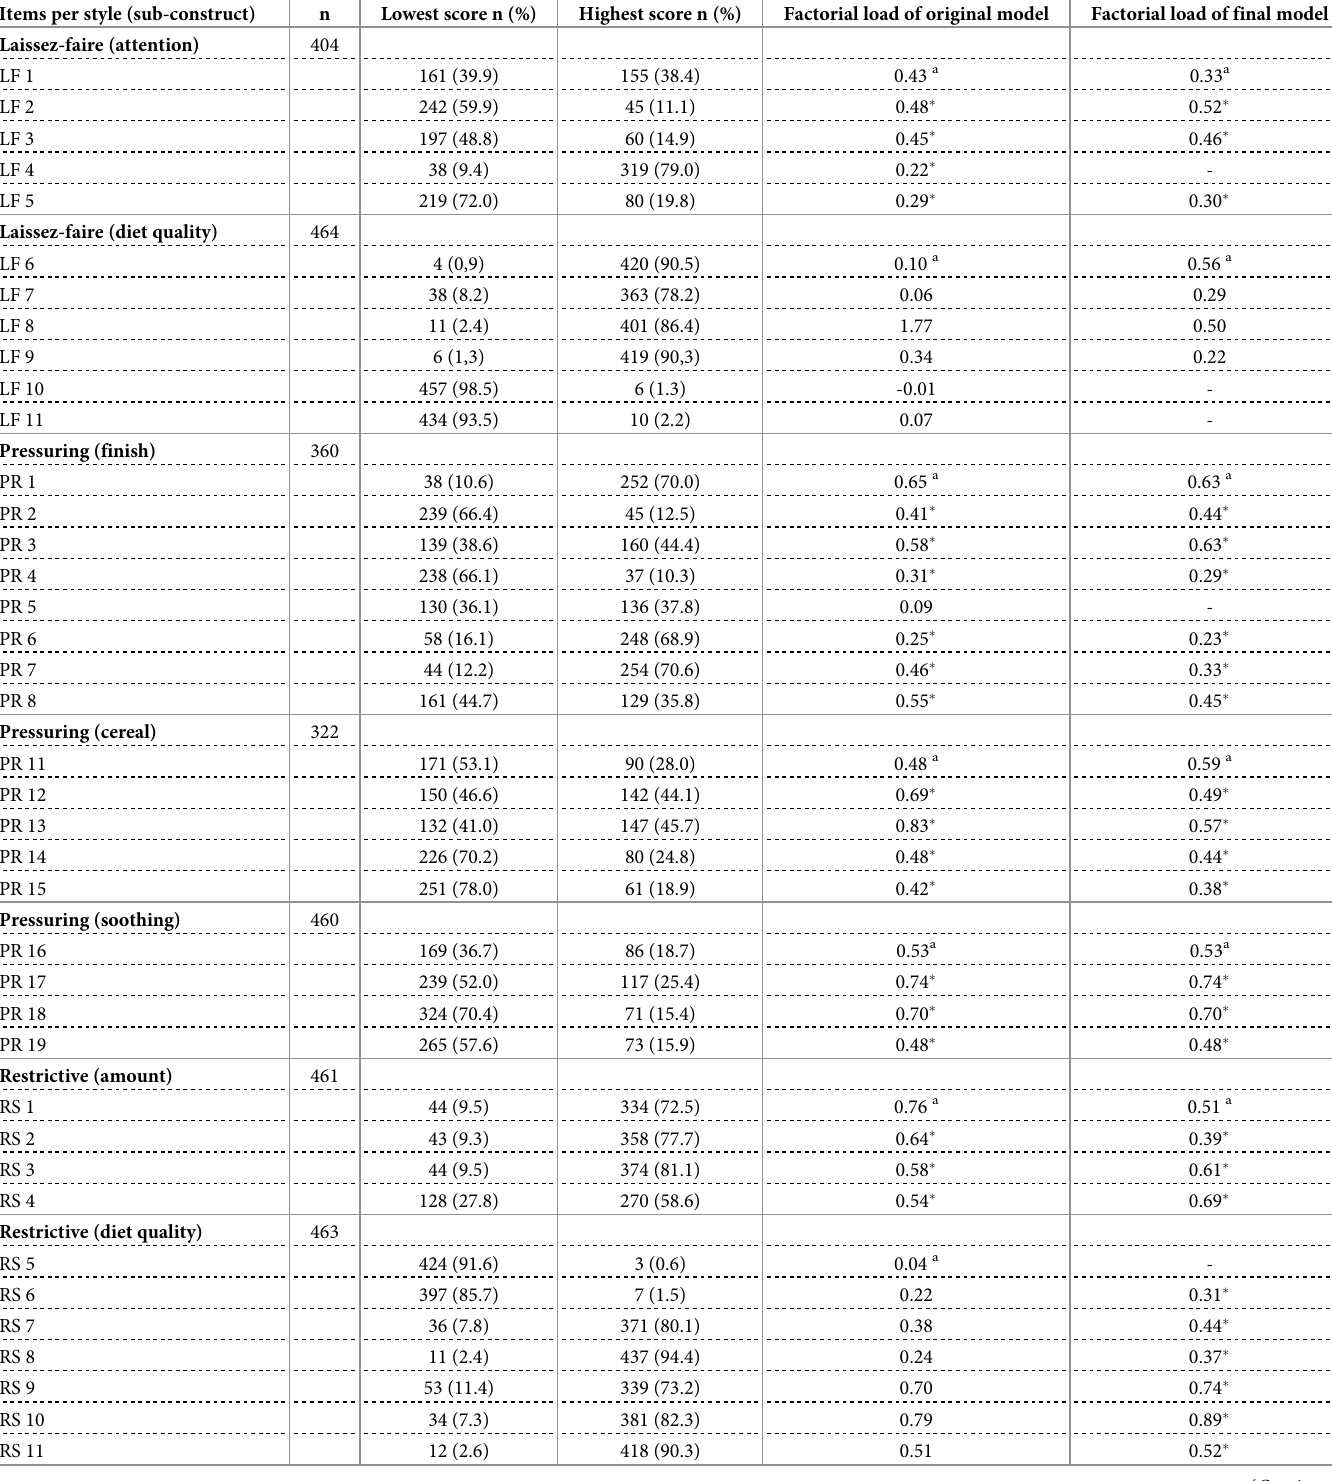
Table 4. Floor ceiling effect and factor loads of the initial and final models from the Confirmatory Factor Analysis for each sub-construct of the Brazilian Portu- guese version of the Infant Feeding Style Questionnaire (IFSQ-Br). Federal District, Brazil.